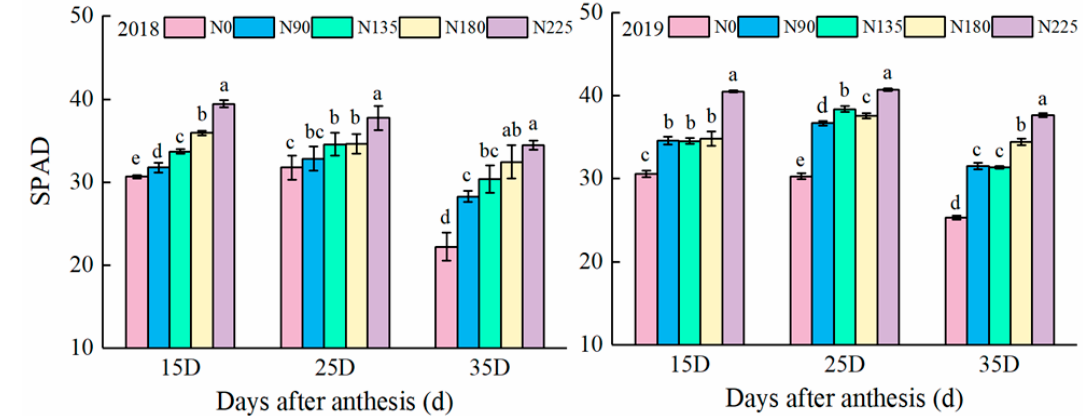
Figure 3. The effect of different nitrogen application rates on the SPAD of rice in different growth progresses. Lower case letters indicate that the physical and chemical properties of the low-gluten rice are significantly different with the different treatments ( p < 0.05, LSD method).